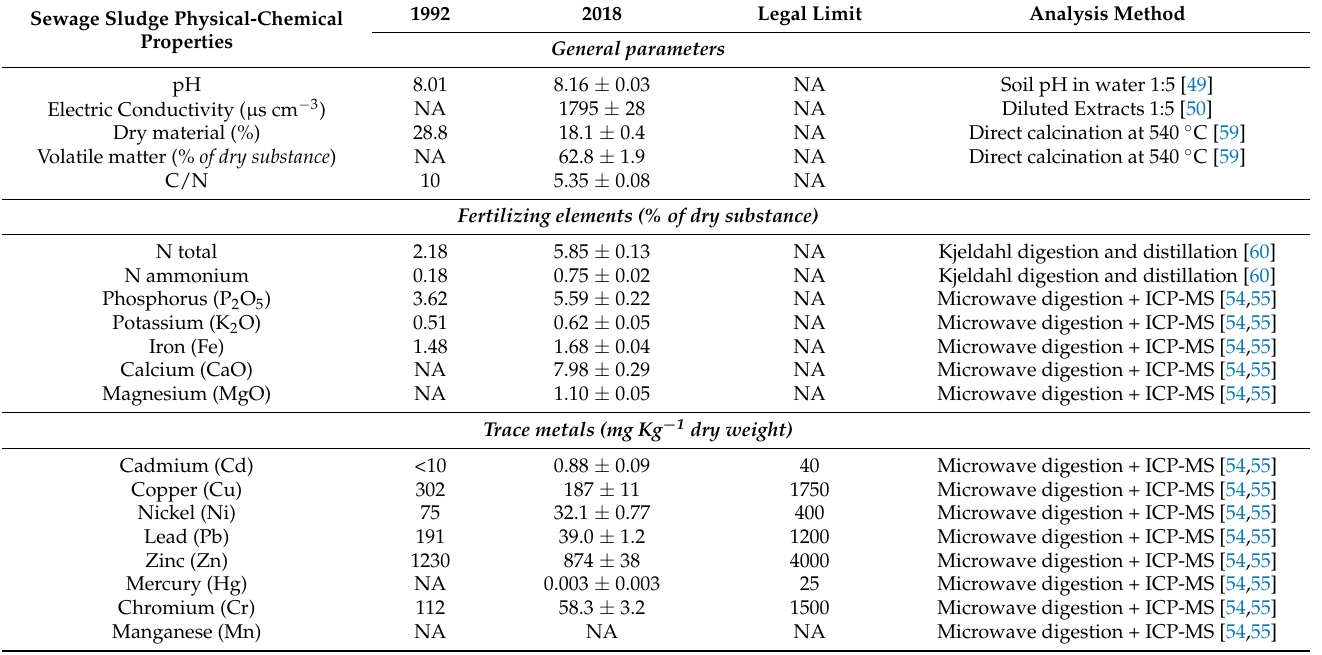
Table 3. Physical-chemical properties of the sewage sludge (SS) used in this study in 1992 (start of the experiment) and 2018 (sampling) together with the analytical methods used. Mean annual values ± standard deviation. The maximum legal limits of TM allowed in SS intended for agricultural use are indicated for each